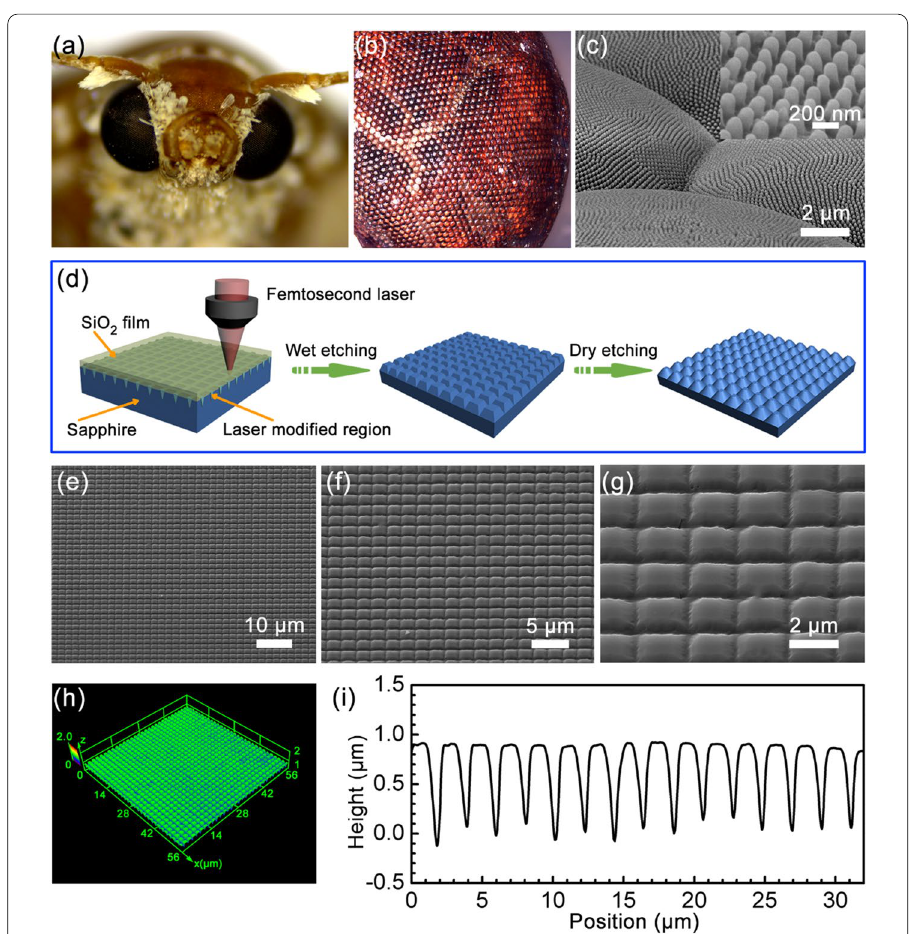
Fig. 4 a Photograph of the compound eye (moth). b LSCM image and ( c ) SEM image of the moth eye. The inset of ( c ) is the high‑resolution SEM image of the surface microstructures on the moth eye. d Schematic illustration of the fabrication procedure of an antireflection sapphire surface with sub‑wavelength microstructures. e-g SEM images of the sub‑wavelength structures on sapphire. h 3D morphology and ( i ) cross‑section profile of the biomimetic sapphire surface with sub‑wavelength